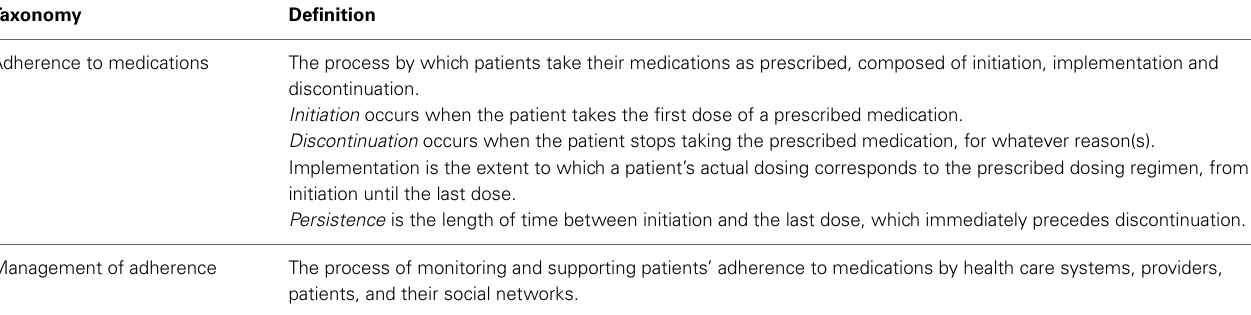
Table 4 | Summary of the taxonomy and definitions of medication adherence ∗